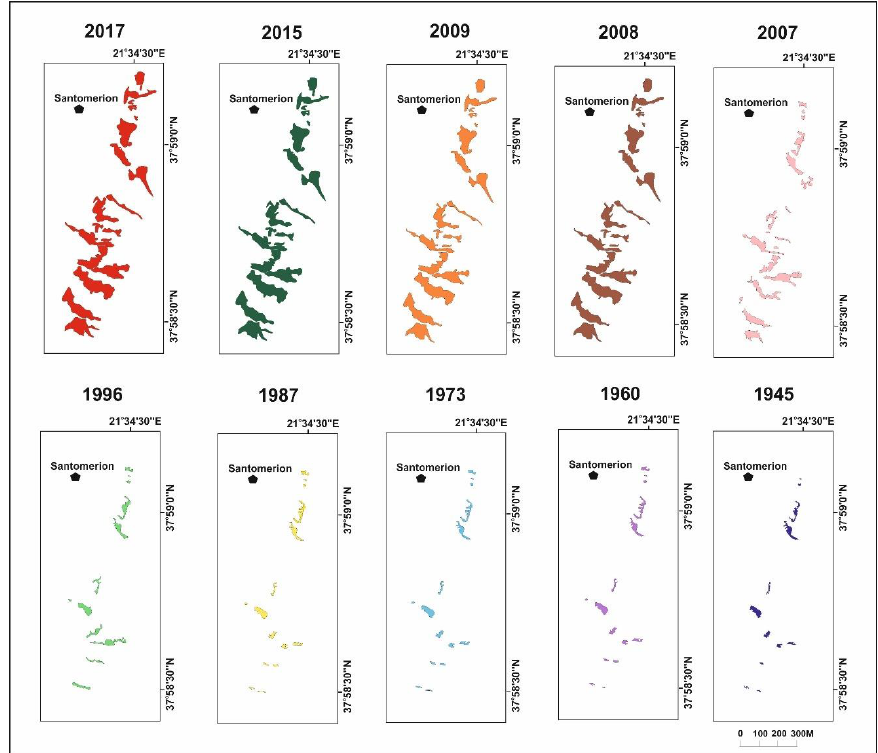
Figure 5. The evolution of the 21 landslides mapped from the orthomosaics during the 1945–2017 close to the Santomerion Village.